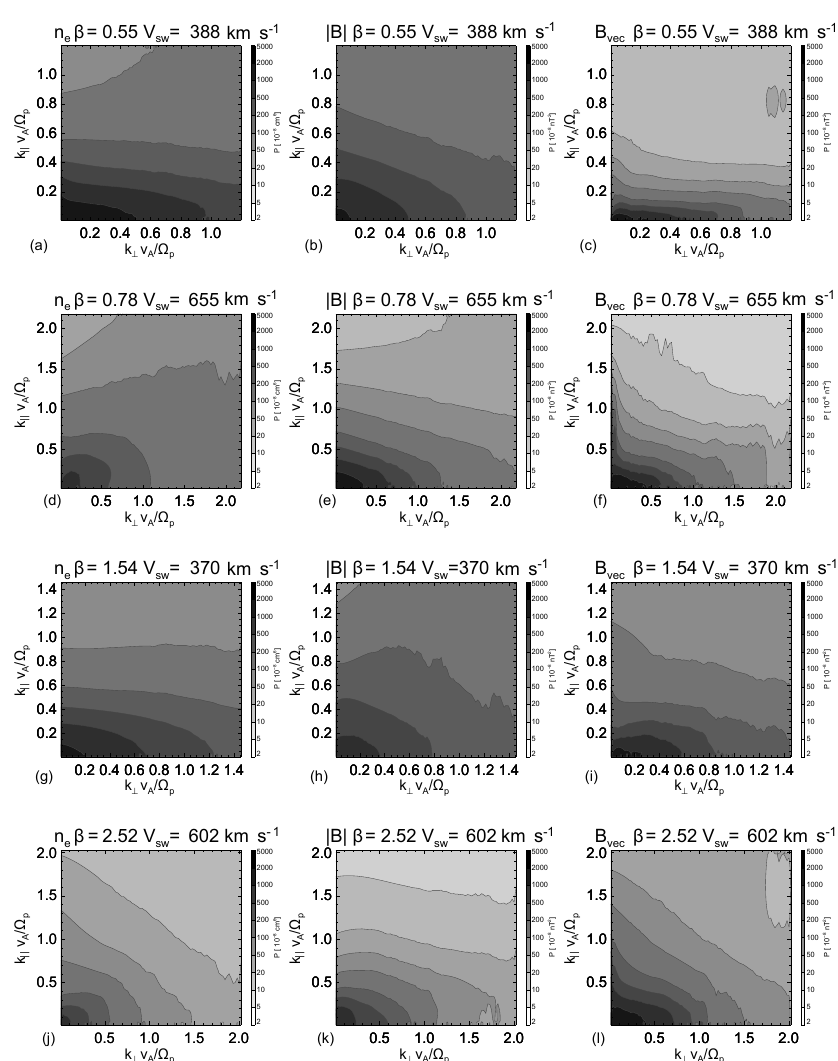
Figure 1. Reduced two-dimensional spectra which have been integrated in frequency and integrated azimuthally as described in Eq. (1). For three different intervals, the morphology is investigated for the compressible density fluctuations (a, d, g, j) , the compressible (magnitude) of the magnetic field (b, e, h, k) and the total magnetic field which we use as a proxy for the incompressible fluctuations (c, f, i, l)